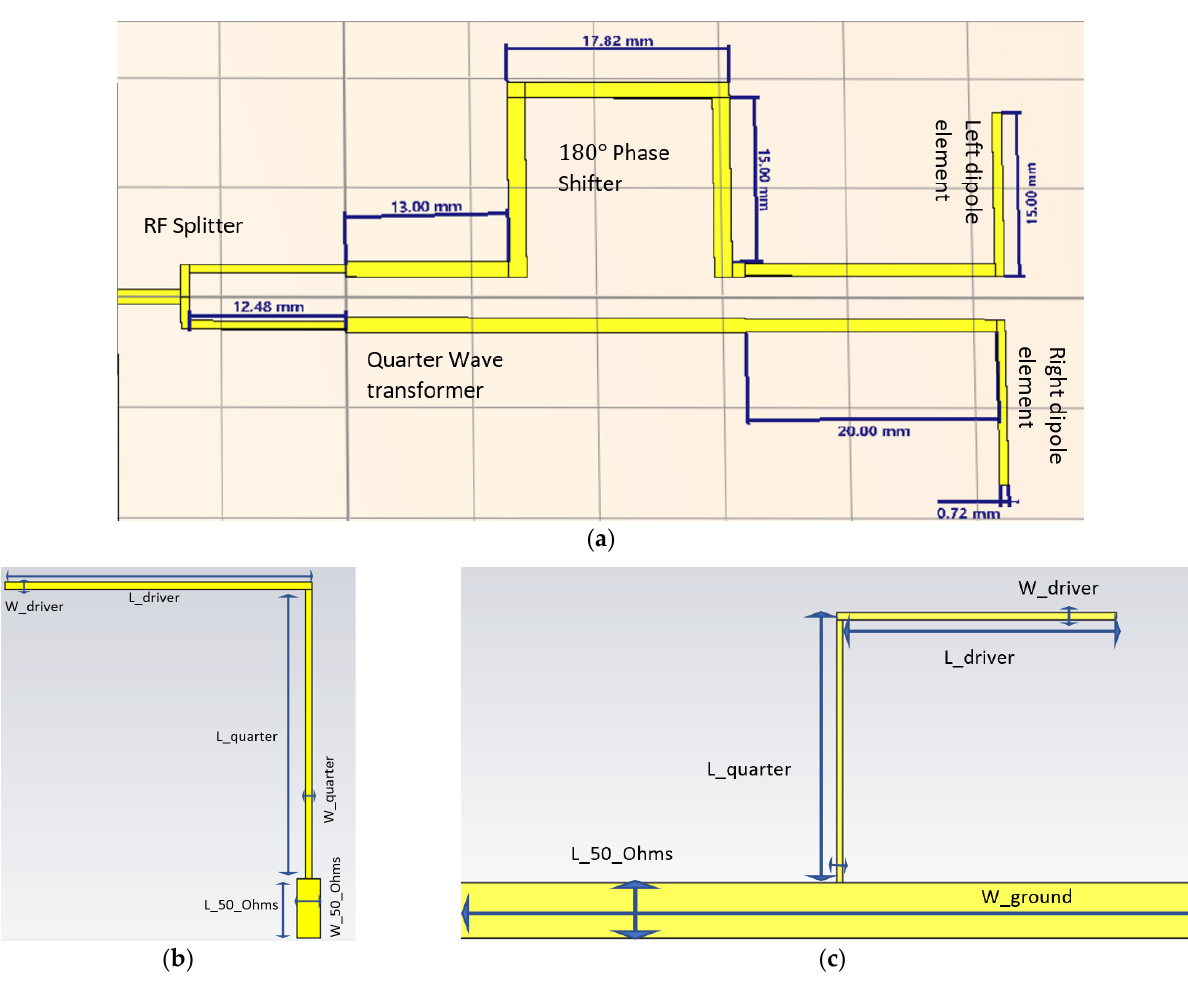
Figure 3. ( a ) One-sided dipole antenna implementation fed by Phase Shifter and Splitter microwave components; ( b ) Top views of an antipodal dipole antenna without splitter and phase shifter components; ( c ) Bottom view of the antipodal dipole antenna including a rectangular ground.